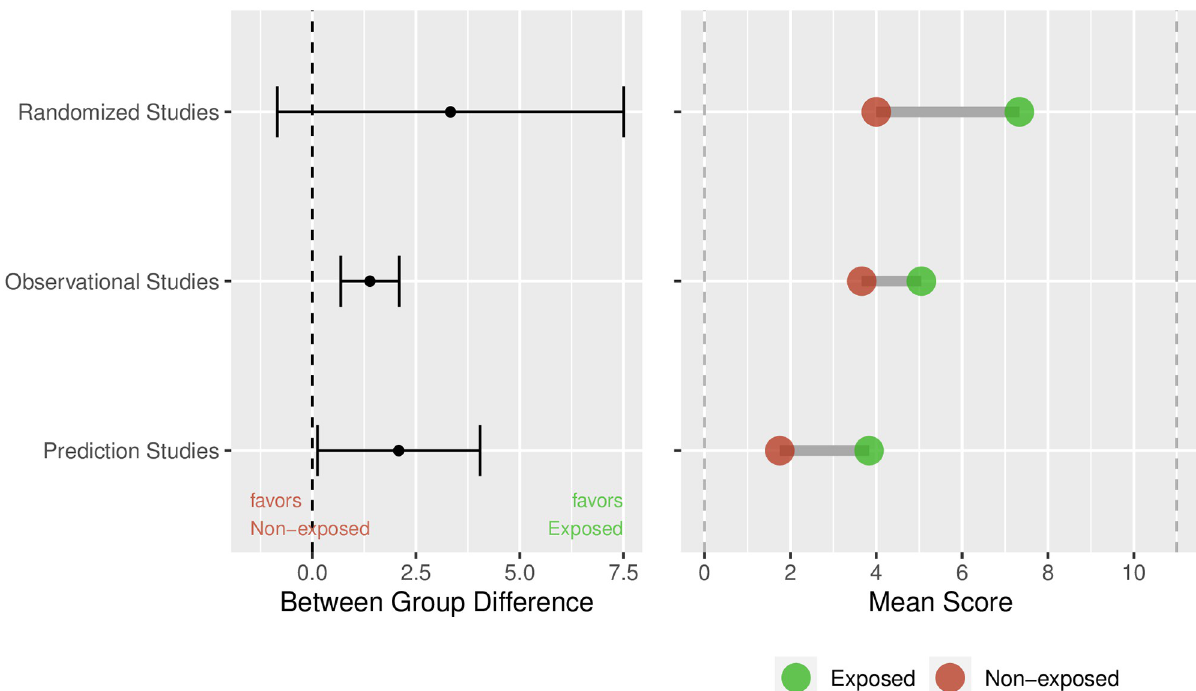
Fig 2. Estimated between-group difference with 95%CI in the pre-specified subgroups of study type (left); raw means in exposed and non- exposed publications (right). Unit of analysis is publication.